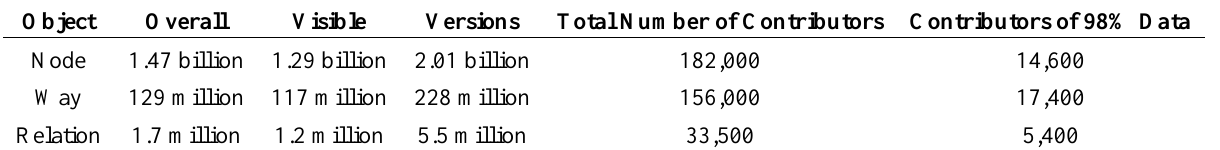
Table 1. Statistics of the OSM database (December 2011).